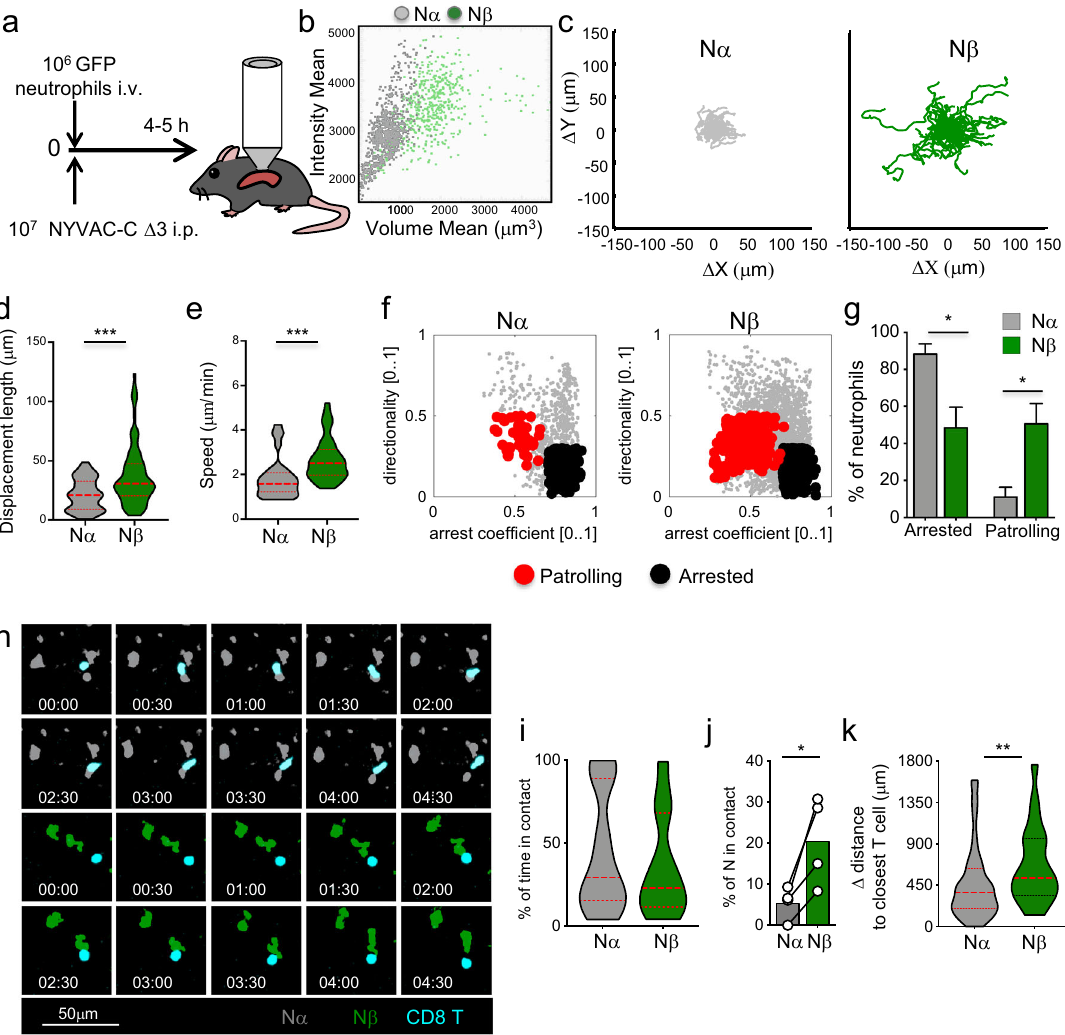
Fig. 3 Distinct dynamic behaviors from different neutrophil subtypes. 10 6 GFP + neutrophils isolated from UBC-GFP mice were intravenously (i.v.) injected in C57BL6/J mice that were i.p. infected with 10 7 PFU of NYVAC-C Δ 3 virus and the spleen was imaged from 4 to 5 h post infection ( a ). Multiphoton intravital microscopy dot plot determined by intensity and volume mean of GFP + neutrophils from spleen of NYVAC-C Δ 3-infected mice ( b ). Cell track plot of N α and N β neutrophil from spleen of NYVAC-C Δ 3 infected mice from 4 to 5 h post infection ( c ). Violin plots of displacement length ( μ m) ( d ) and speed ( μ m/min) ( e ) of N α and N β neutrophils from 4 to 5 h post infection. Dot plots based on directionality and arrest coef fi cient of neutrophil subset activities (arrested: black; patrolling: red) ( f ). Percentages of arrested and patrolling N α and N β from 4 to 5 h post infection ( g ). N α (gray), N β (green) neutrophil and cognate CD8 T cells (cyan) from spleen of NYVAC-C Δ 3- infected mice from 4 to 5 h post infection ( h ). Violin plots of percentage of time in contact of N α and N β ( i ), graph bars of percentage of N α and N β in contact with CD8 T cells ( j ), and violin plots of differential distance of N α and N β to closest T cell ( k ). Graphs show mean ± SEM; each point represents an individual mouse. Data are representative of three independent experiments. * P < 0.05, ** P < 0.01, *** P <